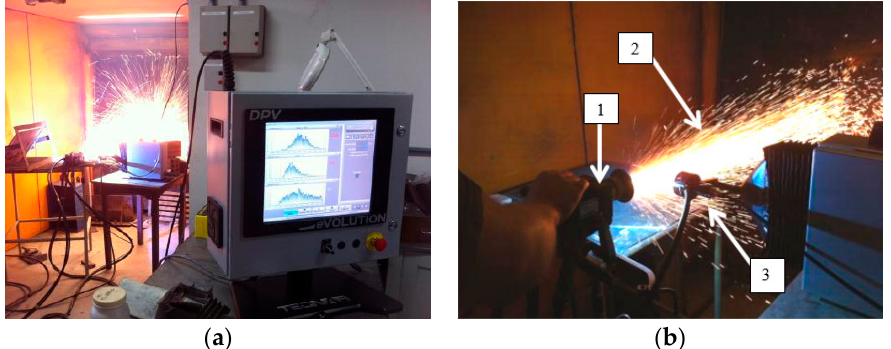
Figure 3. Tecnar DPV Evolution equipment assembly for the ASP process. ( a ) Monitor presenting results online; and ( b ) position of the sensor, with 1—ASP gun; 2—plume; and 3—DPV sensor.